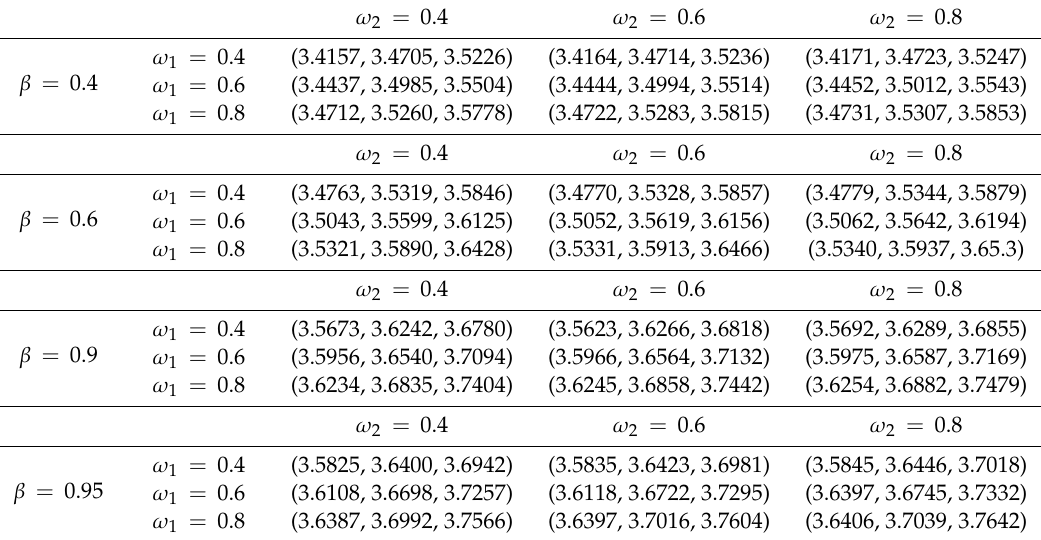
Table 3. System costs obtained from the fuzzy random conditional value-at-risk-based linear programming (FCVLP) model ($10 8